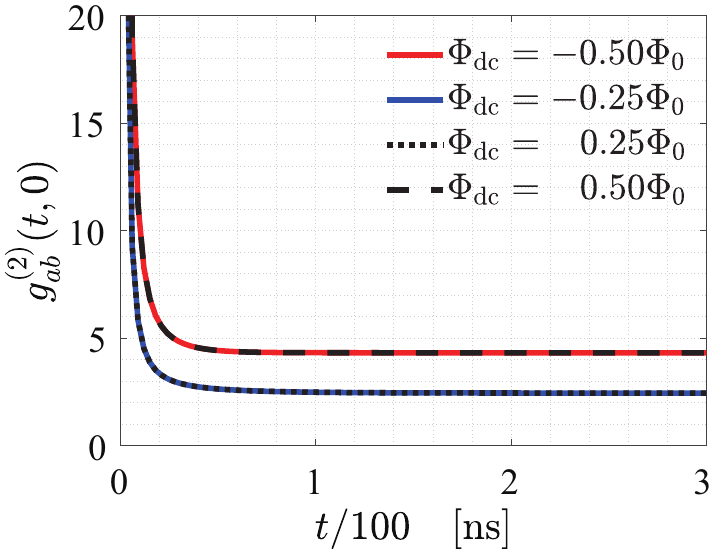
( 2 ) ( t ,0 ) of the output photons at dc working points ab